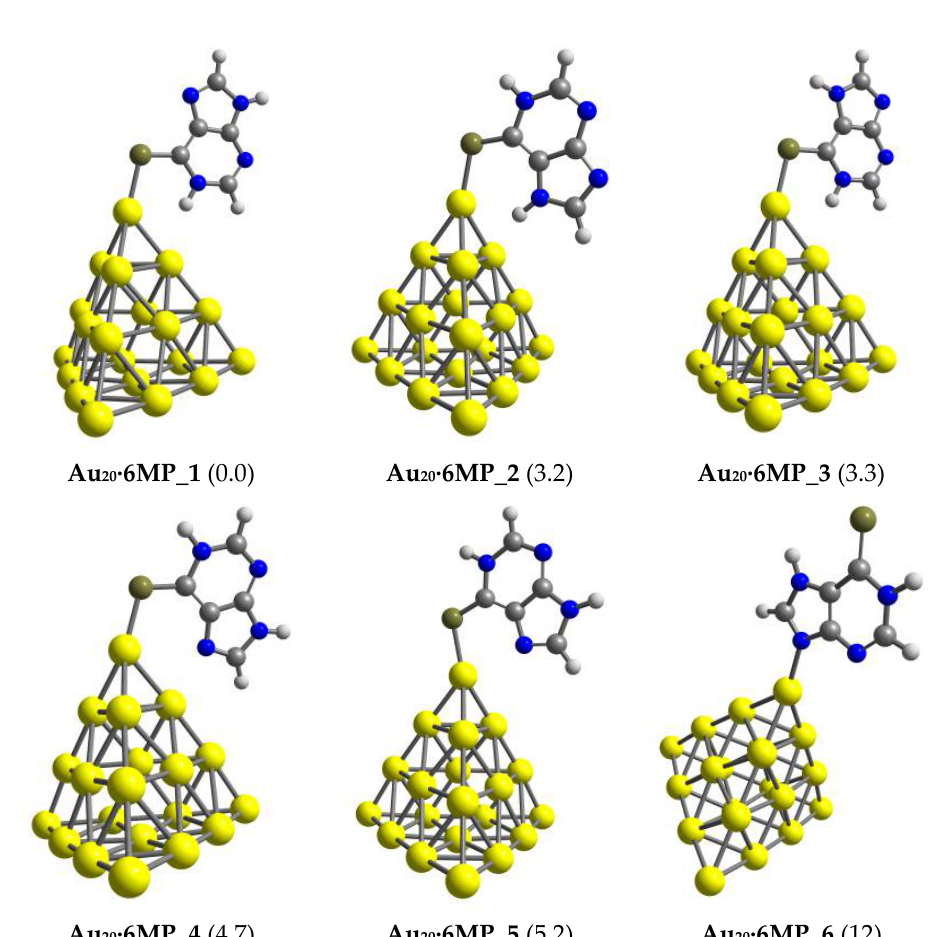
Figure 3. Lower-lying structures of the Au 20 ∙6MP complex in the gas phase. Values given in parentheses are their relative energies in kcal/mol from PBE computations. The yellow, gray, blue, lime, and white balls represent Au, C, N, S and H atoms, respectively.